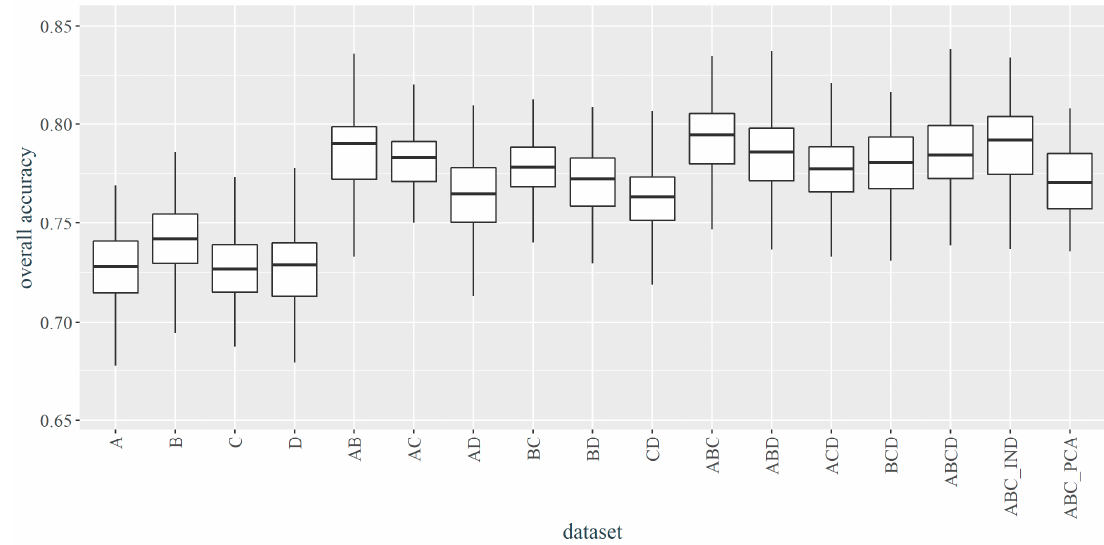
Figure 3. Overall accuracies obtained during the 100-times iterative procedure of accuracy assessment for each dataset.